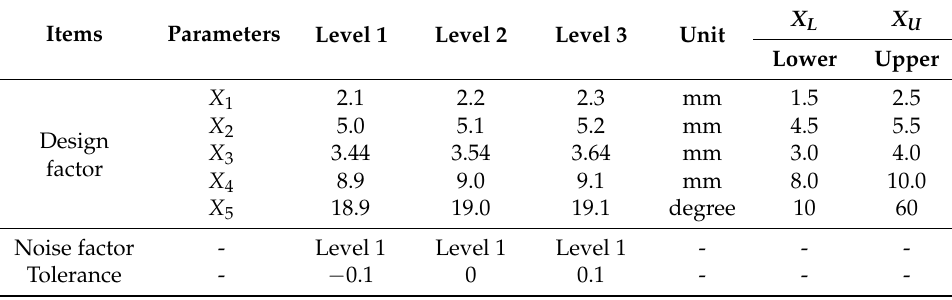
Table 3. Design and noise factors of the BLDC